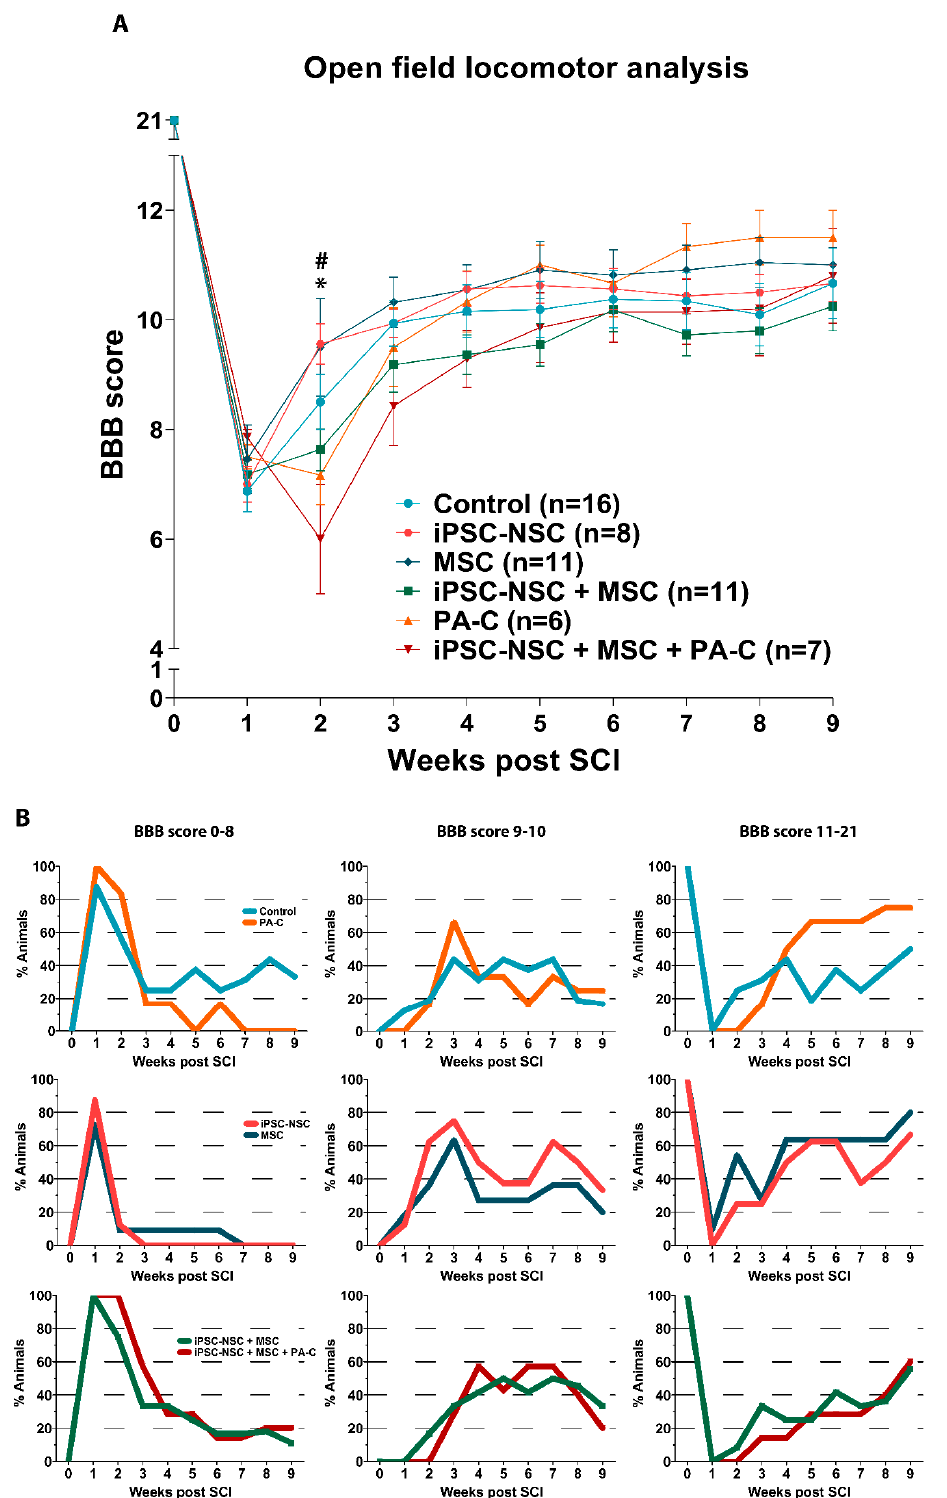
Figure 5. Locomotor recovery after SCI following single treatments and combination therapy. ( A ). Time course locomotor evaluation by open-field BBB scale over nine weeks post-SCI. ( B ). BBB locomotor evaluation subdivisions (0–8, 9–10, and 11–21) showing the percentage of animals in each score range. Treatments compared at all post-injury time points. Data expressed as mean ± S.E.M. (control n = 16; iPSC-NSC n = 8; MSC n = 11; iPSC-NSC + MSC n = 11; PA-C n = 6; iPSC-NSC + MSC + PA-C n = 7) determined by two-way mixed model ANOVA with Tukey’s multiple comparison test (* p < 0.05 iPSC-NSC vs. PA-C; # p < 0.01 iPSC-NSC vs. iNSC +